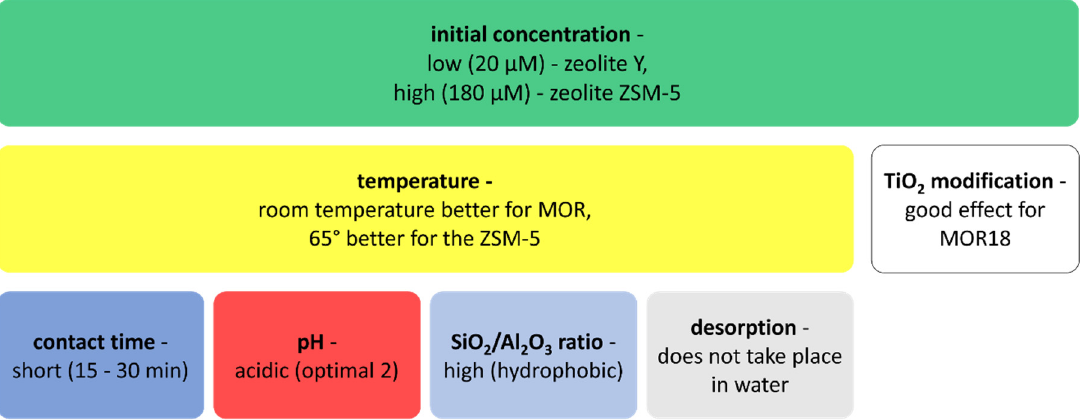
Figure 5. Factors influencing the sorption of sulfamethoxazole on zeolites: FAU-1, FAU-2, zeolite Y, MOR, ZSM-5, TMOR18, and TMOR240.